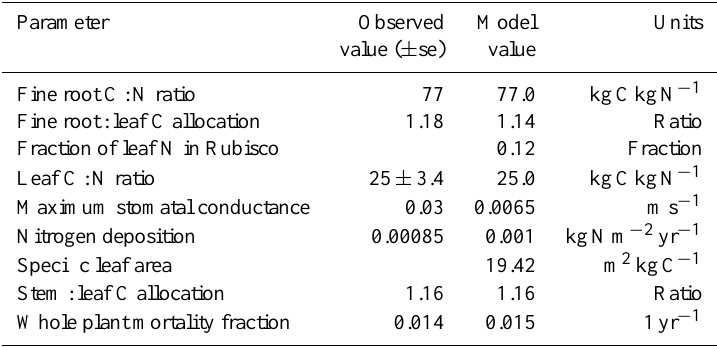
Table 2. Selected site-specific parameters used by Biome-BGC. Model inputs differ from observed values because of the optimization procedure used (see Methods section).